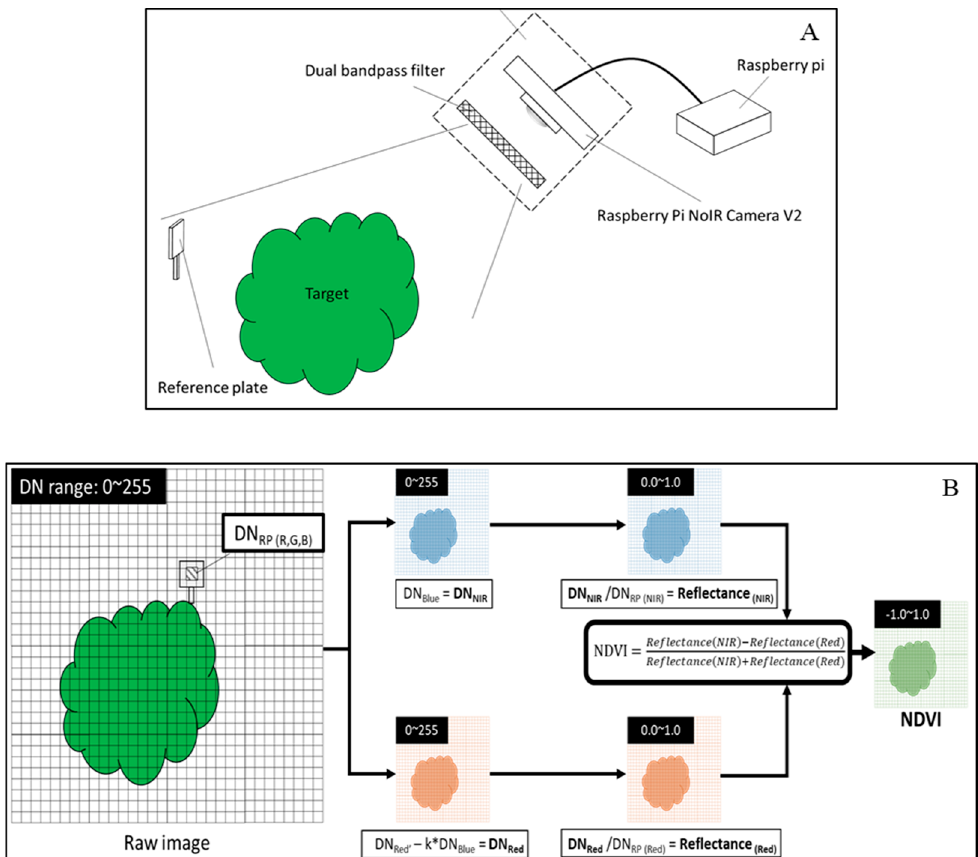
Figure 2. Camera setting ( A ) and calculation process ( B ) of NDVI.